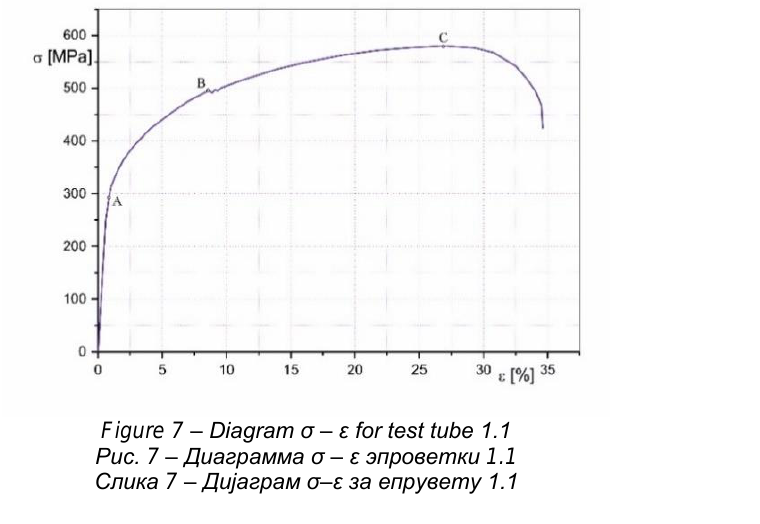
Figure 7 – Diagram σ – ε for test tube